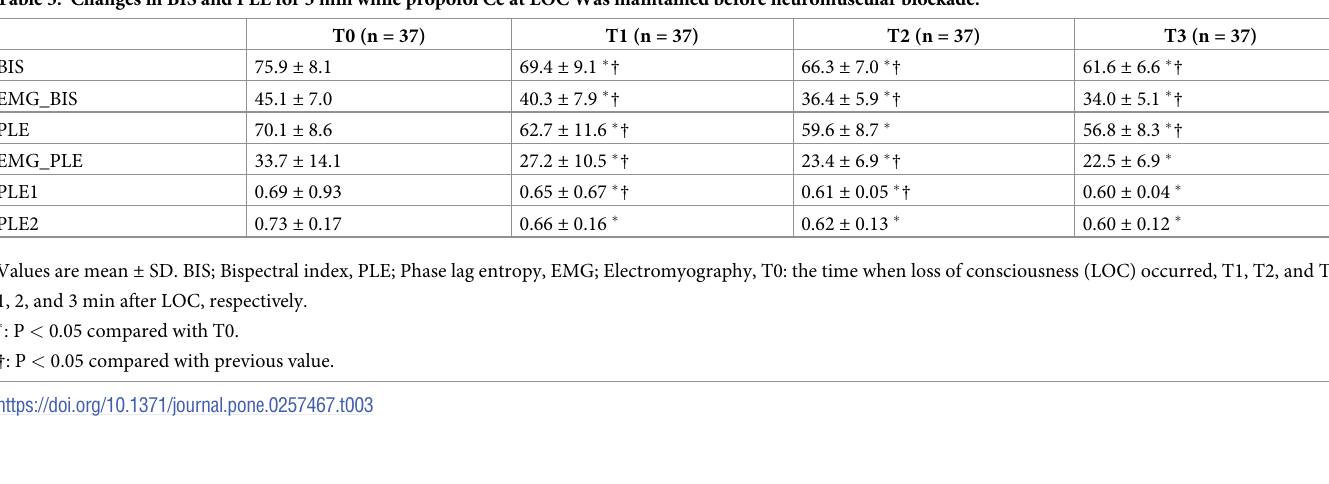
Values are mean ± SD or number (% of group). Group C: group who received same volume of normal saline as rocuronium, Group R: group who received rocuronium 0.6 mg/kg. There were no significant differences between the two groups.